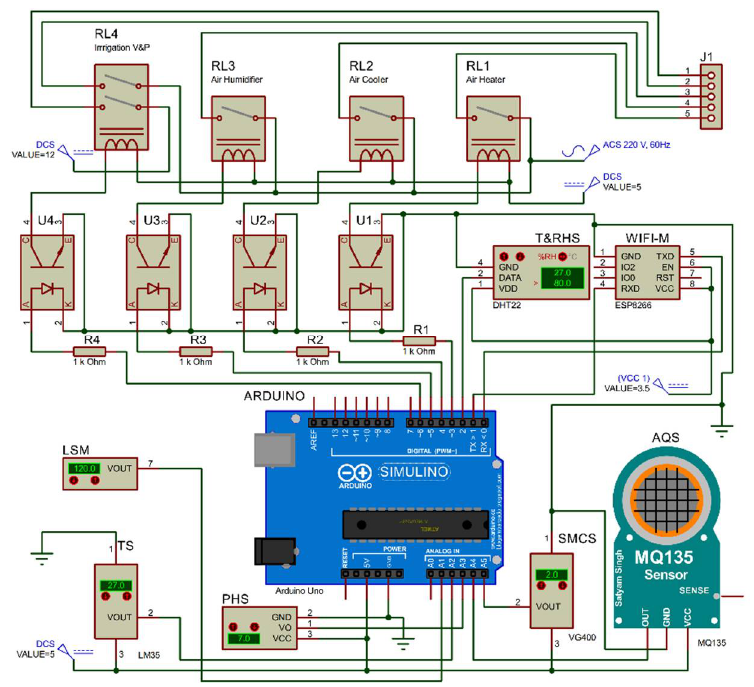
Figure 3. The schematic Proteus simulation diagram with the main components of the control and monitoring of the E-VAS. RL1, RL2, RL3, and RL4 are the relays for the heater, the cooler, the humidifier, and the irrigation control, respectively, U1, U2, U3, and U4 are the optocouplers, R1, R2, R3, and R4 are the 1 k Ohm resistors, ARDUINO is the Arduino UNO microcontroller with ATmega328P Microchip, LSM is the FUT3101 light sensor module, TS is the LM35 temperature sensor, PHS is the DX-250 pH sensor, SMCS is the VH400 volumetric substrate moisture sensor, AQS is the MQ135 air quality sensor, VCC1 is the 3.5 V DC power source, DCS is the DC power source, ACS is the 220 V AC power source, and WIFI-M is the ESP8266 NodeMCU board.